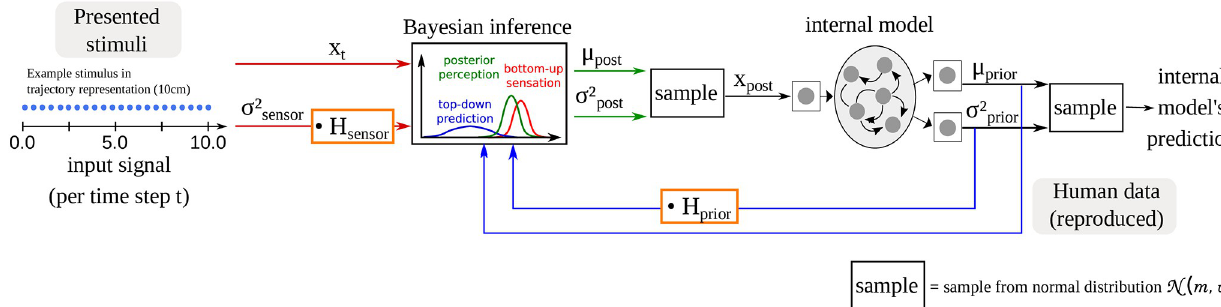
Fig 1. An overview of the computational model used in the present paper: A recurrent neural network serves as the internal model that learns to predict future time steps of a one-dimensional trajectory whose length represents the length of the stimuli.